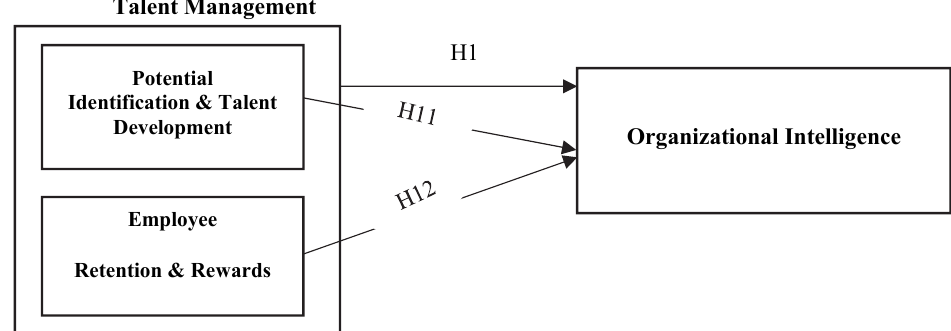
Fig. 1. Proposed Model of